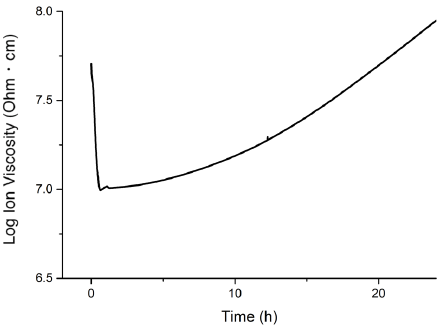
Figure 5. Dielectric Analysis curve of 40 wt.% tung oil, 30 wt.% n ‐ butyl methacrylate (BMA), 20 wt.% DVB, and 10 wt.% asolectin heated at 100 °C for 24 h.